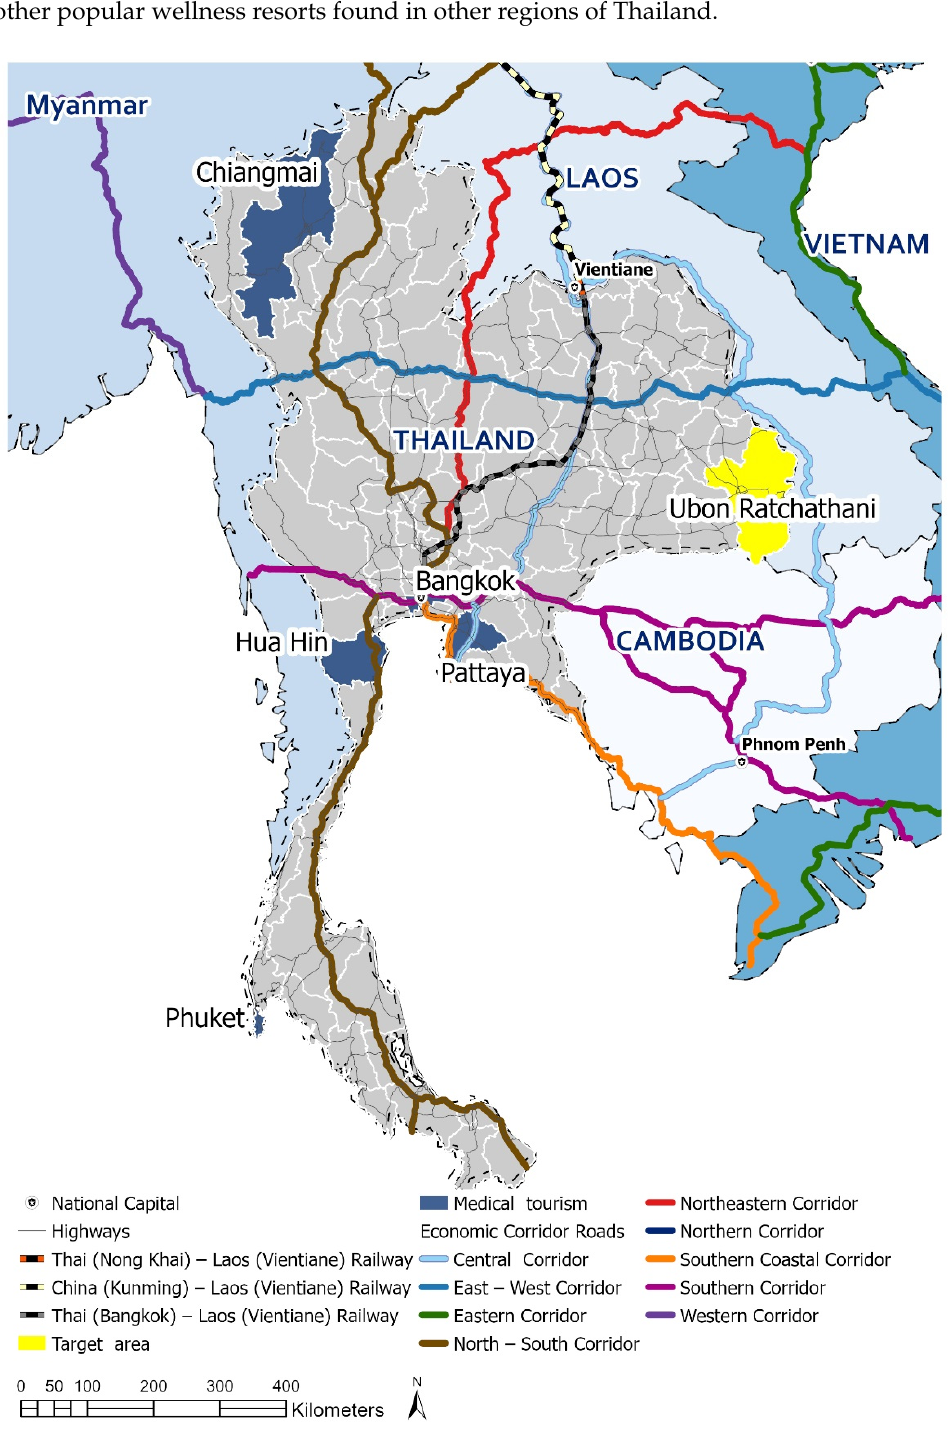
Figure 1. Main roads and borders of GMS region. (source: Environment Operation Center, www.gms-eoc.org, access date 20 July 2022).